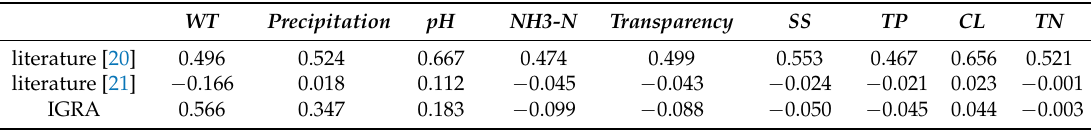
Table 1. The relational analysis results of Tai Lake.